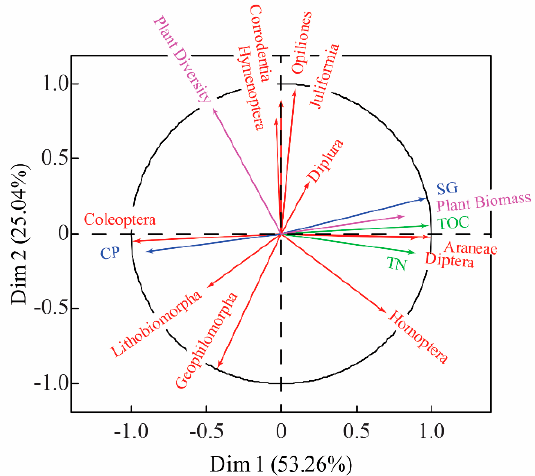
Figure 4. Two-dimensional ordination plot of the multiple factor analysis (MFA) performed for the entire data set, including environment factors and soil macro-arthropods data. ST: soil temperature; SM: soil moisture; TOC: soil organic matter; TN: Total N; CP: clay particle; SG: sand grains. The percentages shown next to the axis numbers are the total variations in the data explained by that axis.